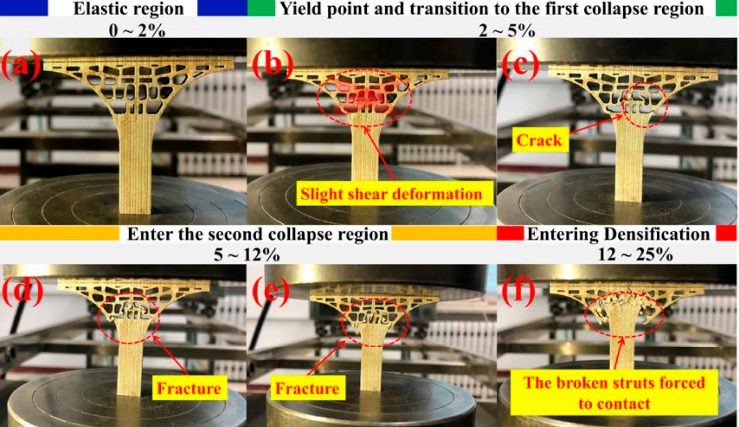
Figure 8. Deformation snapshots of the tree column structures-type AlSi10Mg alloy branches at different deformation stages under compression: ( a ) elastic region, ( b , c ) yield point and transition to the first collapse region, ( d , e ) the second collapse region, ( f ) densified region.